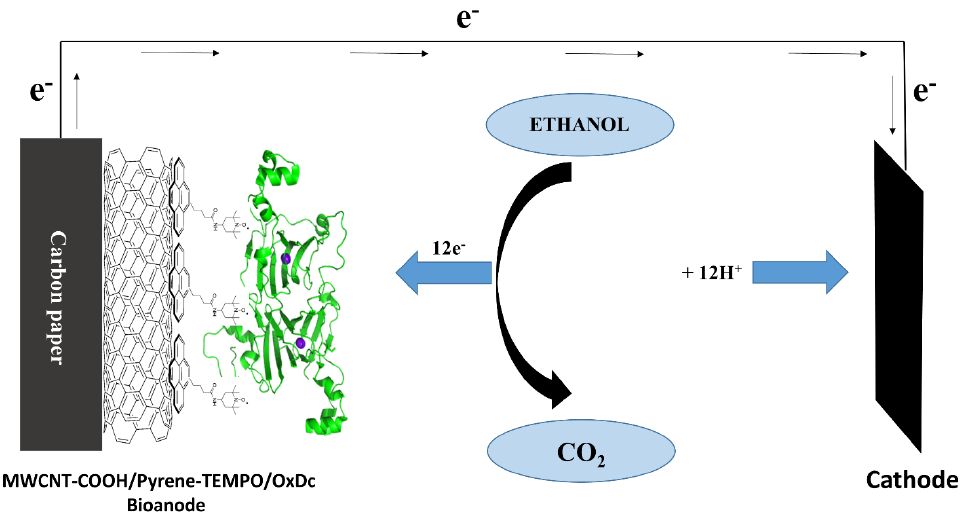
Figure 2. Scheme of complete ethanol oxidation at a hybrid bi-catalytic anode (carboxylated multi-walled carbon nanotube (MWCNT-COOH)/pyrene-2,2,6,6-tetramethylpiperidine-N-oxyl (TEMPO)/oxalate decarboxylase (OxDc)). Scheme 1 depicts the proposed electrocatalytic cascade for ethanol oxidation when a hybrid bi-catalytic architecture is used [34]. The enzymatic pathway acts on the product formed by the TEMPO catalyst. The combination of pyrene-TEMPO and OxDc allows for high-energy production. Furthermore, the introduction of MWCNT-COOH improves the electron transfer rate between the enzymes and the electrode surface.